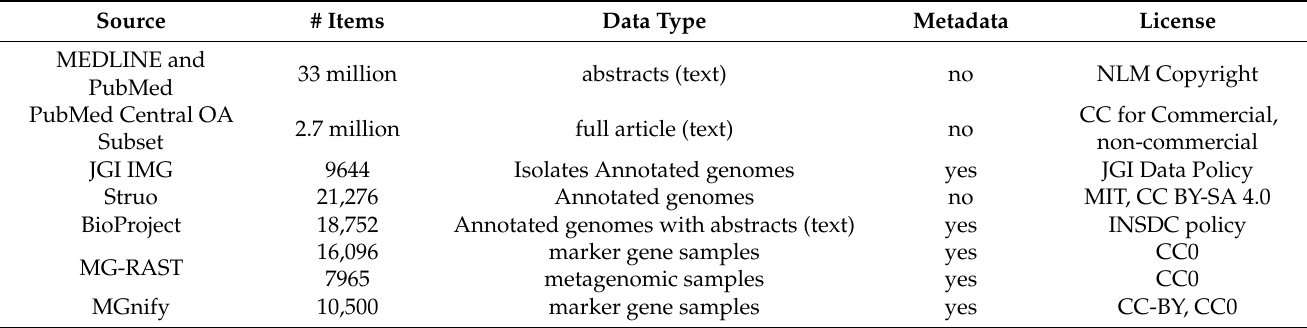
Table 1. Source databases that are integrated in PREGO and the number of items retrieved. The Open Access subset of PubMed Central has a Creative Commons license available for commercial and noncommercial use. JGI has its own license, the same applies for BioProject, MEDLINE ® , and PubMed ® as